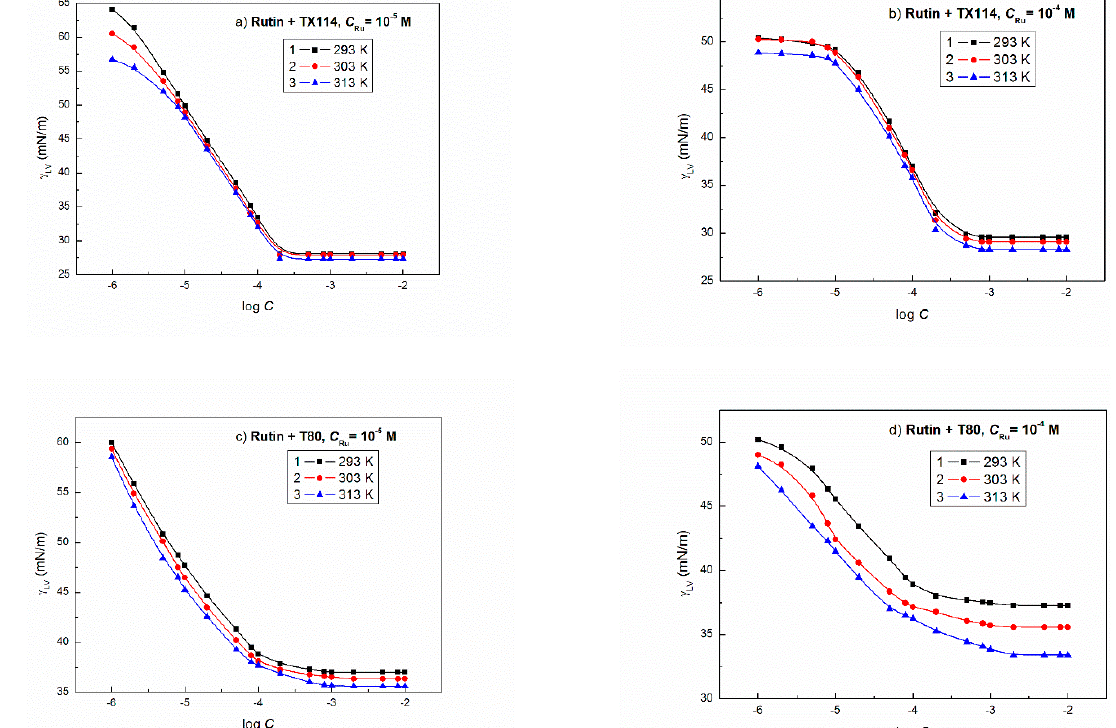
Figure 3. A plot of the surface tension ( γ LV ) of the aqueous solutions of ( a ) Ru + TX114 ( C Ru = 10 − 5 M), ( b ) Ru + TX114 ( C Ru = 10 − 4 M), ( c ) Ru + T80 ( C Ru = 10 − 5 M) and ( d ) Ru + T80 ( C Ru = 10 − 4 M) vs. the logarithm of surfactant concentration (log C ) at different temperatures equal to 293 (curve 1), 303 (curve 2), and 313 K (curve 3), respectively.